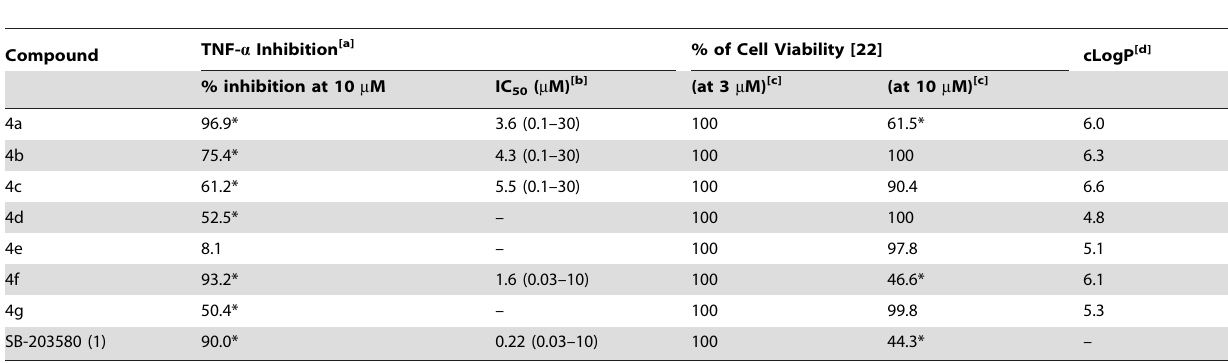
Table 2. Effects of N -phenylpyrazolyl- N -glycinyl-hydrazone derivatives 4a-g on TNF- a production and cell viability in murine peritoneal macrophages.